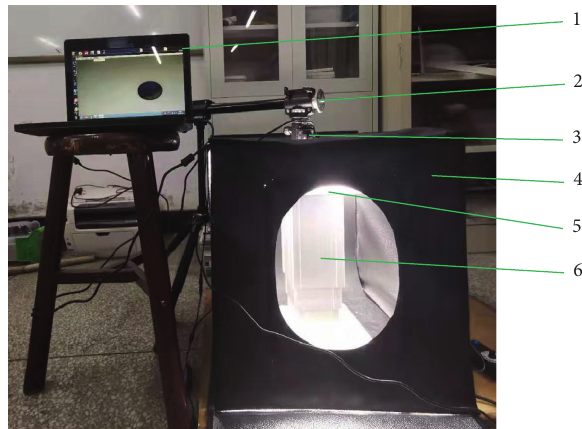
Figure 2: Muskmelon image acquisition setup for indoor dataset.1: computer; 2: tripod; 3: camera; 4: photo studio; 5: LED light bar; 6: lifting platform. Table 1: Dataset details without data